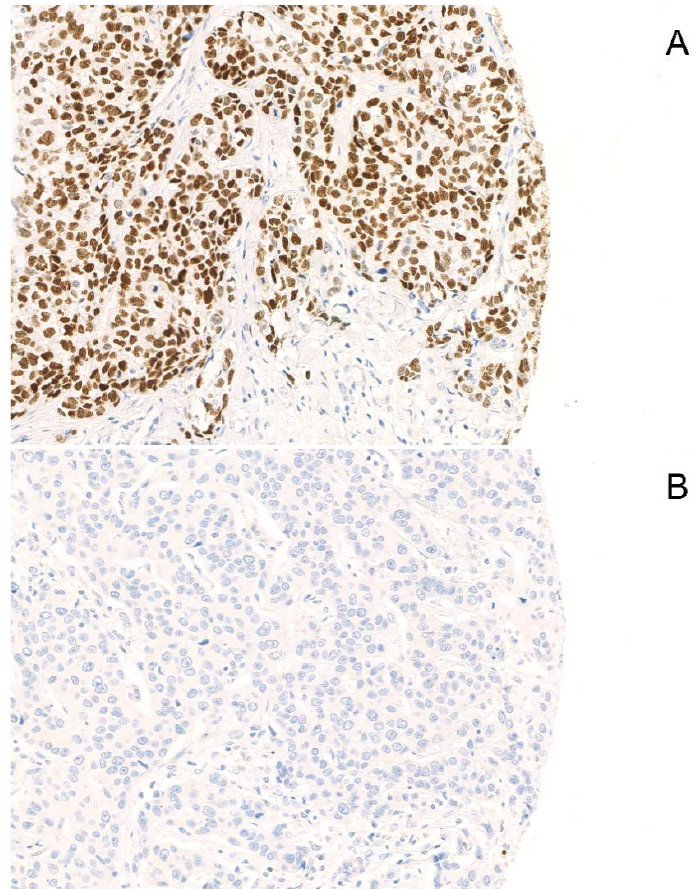
Figure 1. Examples of SOX-10-positive and -negative staining. A typical example of positive ( A ) and negative ( B ) nuclear staining of SOX-10 is displayed (Magnification: 200×).